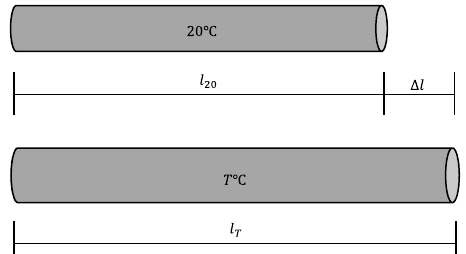
Figure 1. Expansion of an object due to temperature change.